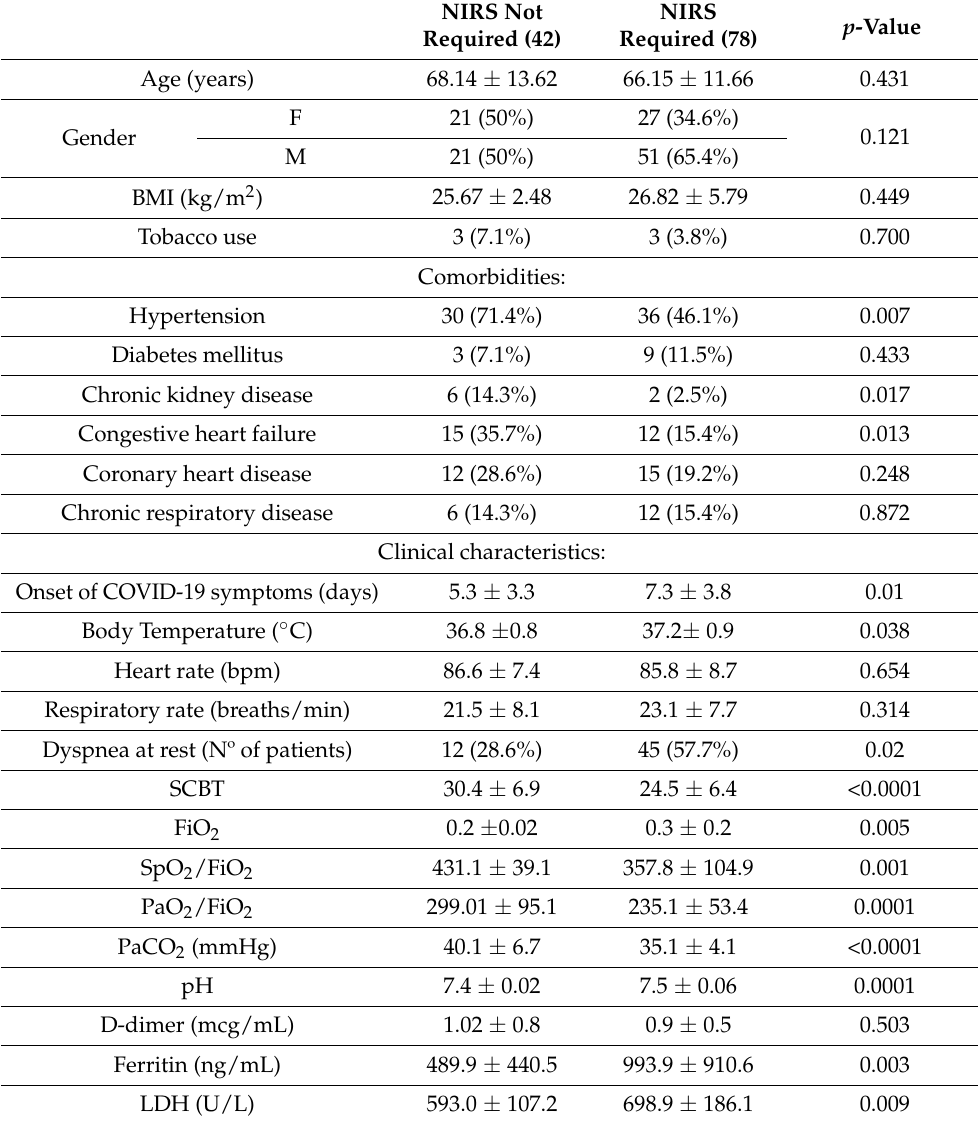
Table 1. Baseline characteristics of patients with COVID-19 pneumonia collected at inclusion into the